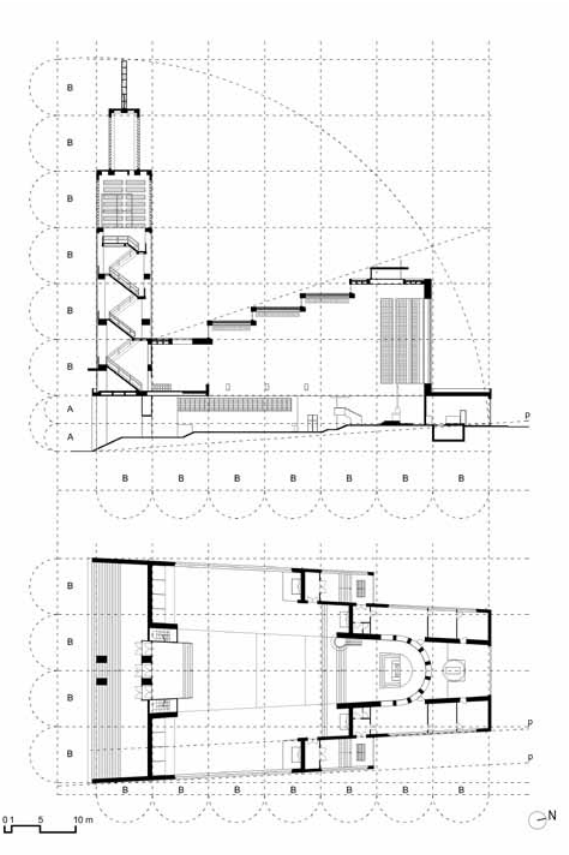
fig. 9. j. Gočár, Church of Saint Wenceslas in Prague, Vršovice, 1928–1929, re-drawing of ground floor plan and longitudinal section